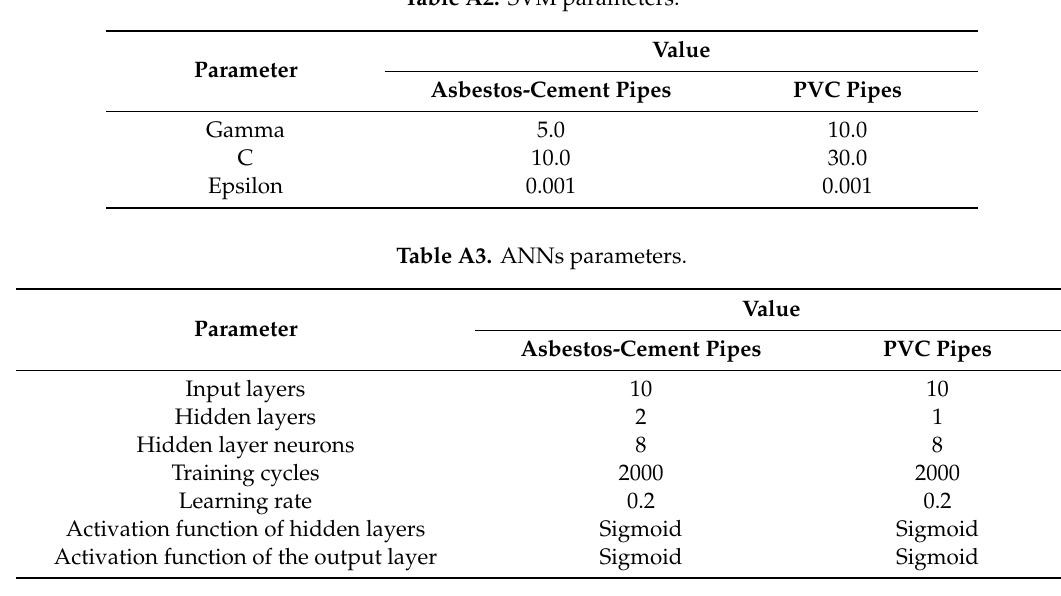
Table A2. SVM parameters.